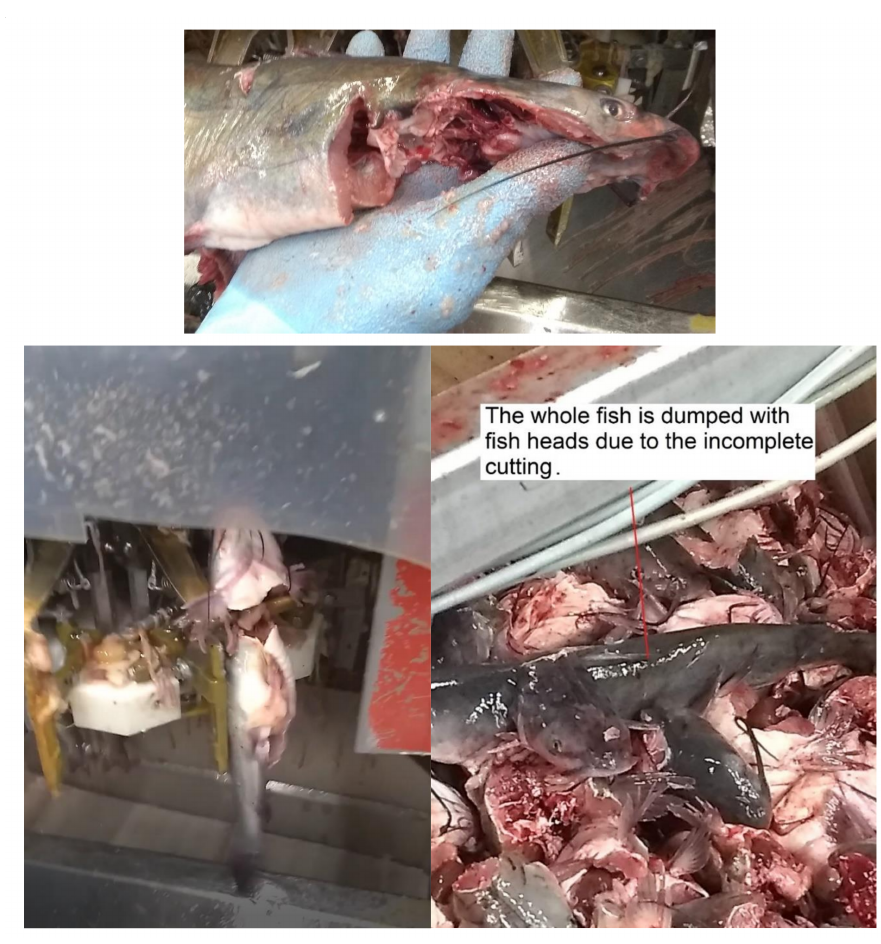
Figure 6. The waste due to deheading